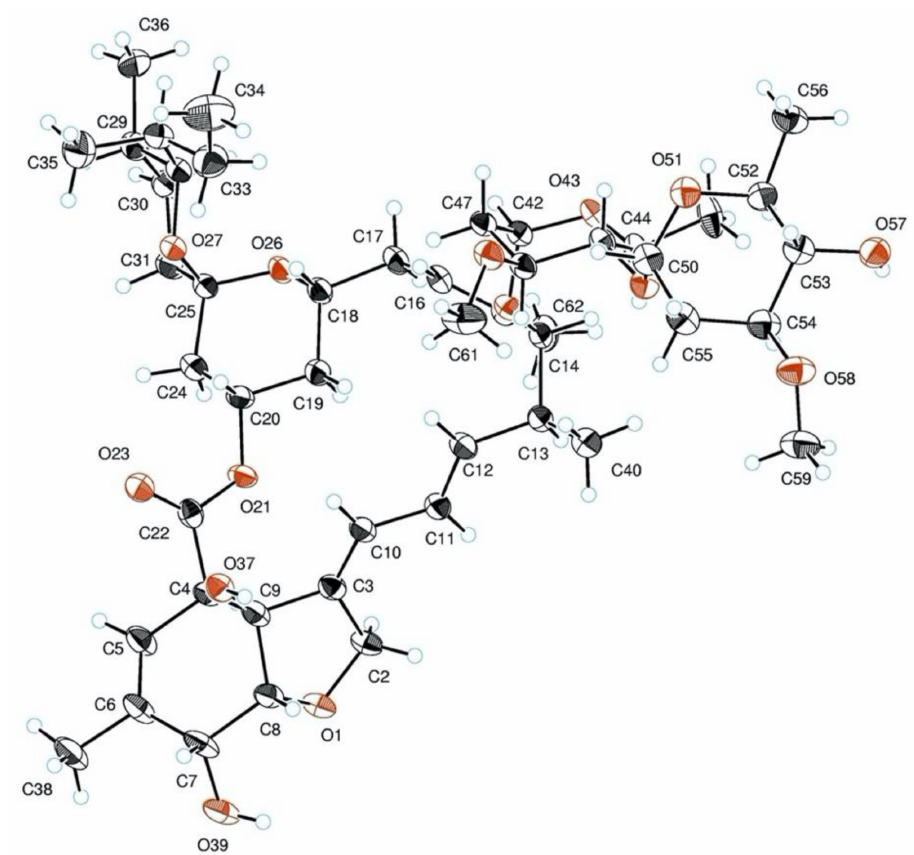
Figure 2. ORTEP diagram of IVM molecule in crystal I showing atomic labels and 50% probability displacement ellipsoids. Hydrogen atoms are shown as small spheres of arbitrary radii.